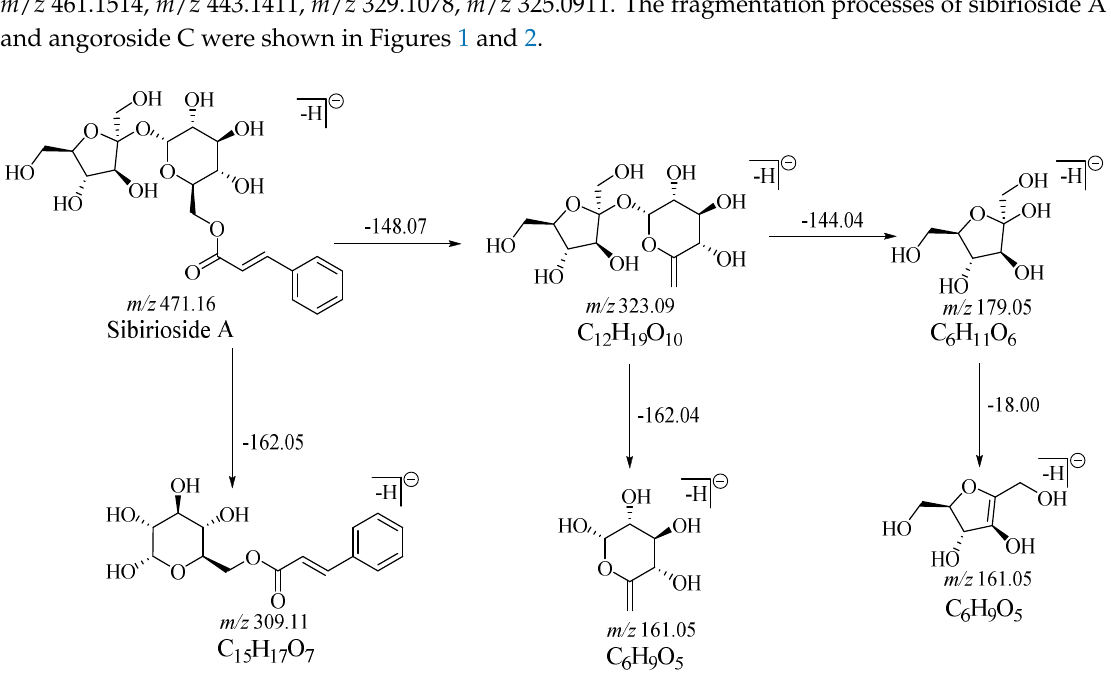
Figure 1. The fragmentation processes of sibirioside A.